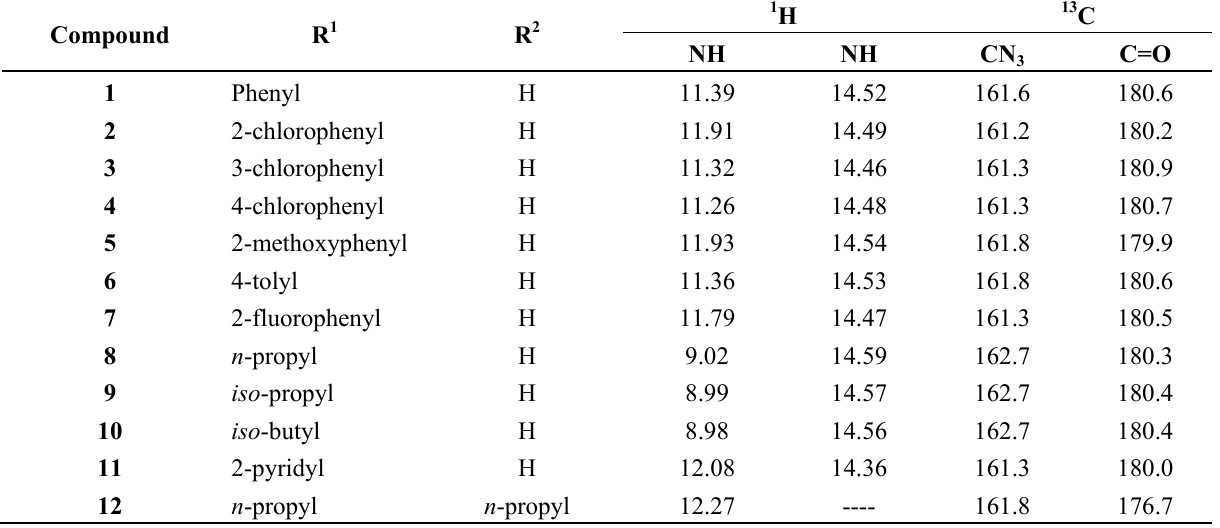
Table 1. Characteristic pyridylguanidine resonances by NMR